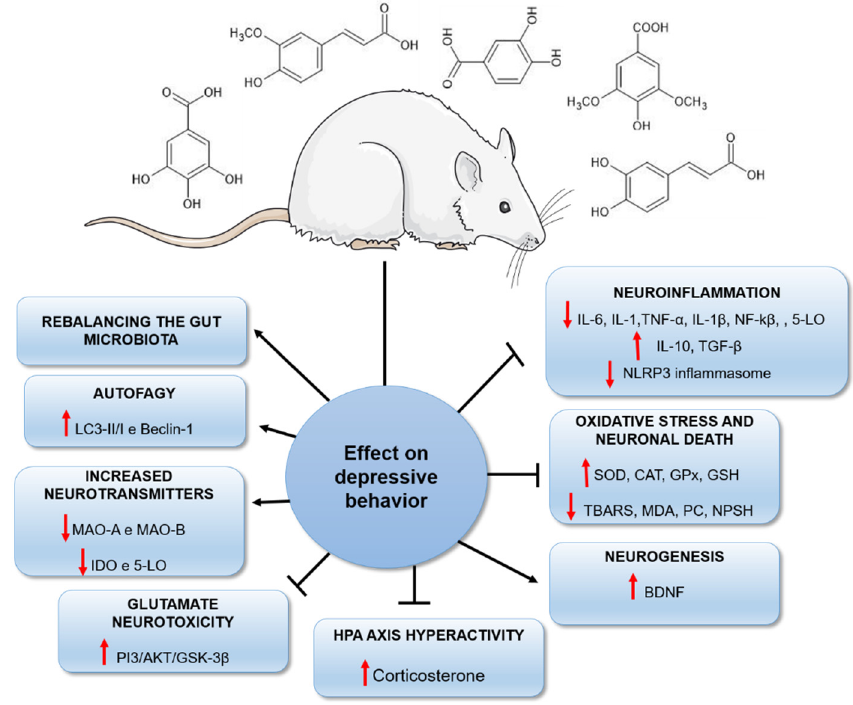
Figure 9. Overall summary, with the main possible molecular mechanisms by which phenolic acids may reduce depressive-like behaviour in rodents. T-shaped arrows stand for inhibition and normal arrows for stimulation. Figure was created using image from Servier Medical Art (https://smart.servier.com) accessed on 16 August 2022, licensed under a Creative Commons Attribution 3.0. The chemical structures were drawn using ChemSketch freeware, version 14.0 from ACD/Labs.